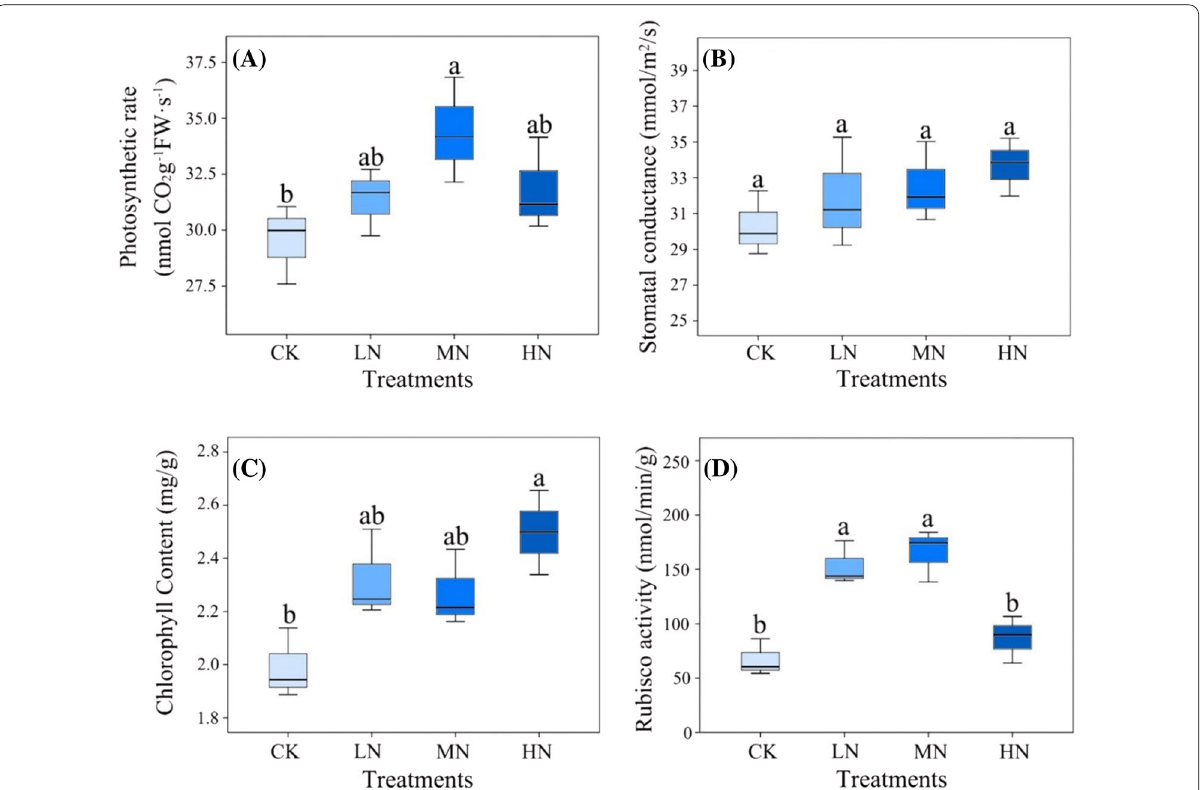
Fig. 4 Effects of nitrogen addition on photosynthetic related indexes of Larix gmelinii . Error bars represent 1 SE of the mean. A The photosynthetic rate of Larix gmelinii . B The stomatal conductance of Larix gmelinii . C The chlorophyll content of Larix gmelinii . D The Rubisco activity of Larix gmelinii . CK, LN, MN, HN represent the control, low N treatment, medium N treatment, and high N treatment, respectively